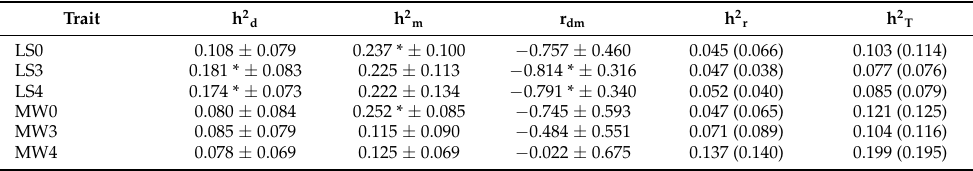
Table 3. Direct, maternal, realized, and total heritability estimates and direct–maternal genetic correlation of littering performances using a single-trait animal model with maternal genetic effects. Trait h 2 d h 2 m r dm h 2 r h 2 T LS0 0.108 ± 0.079 0.237 * ±